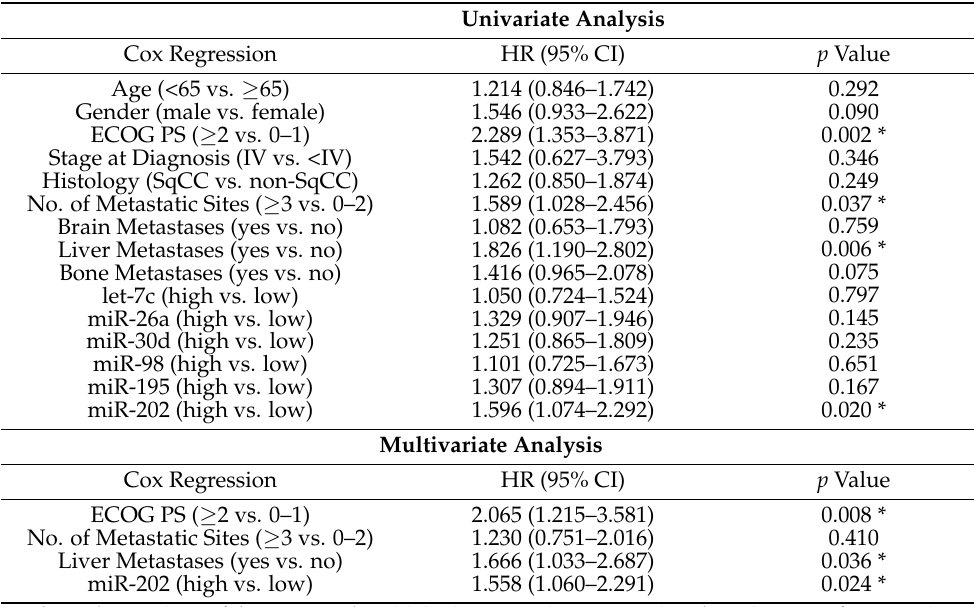
Table 4. Univariate and multivariate Cox regression analysis for overall survival (OS) in NSCLC patients (N =